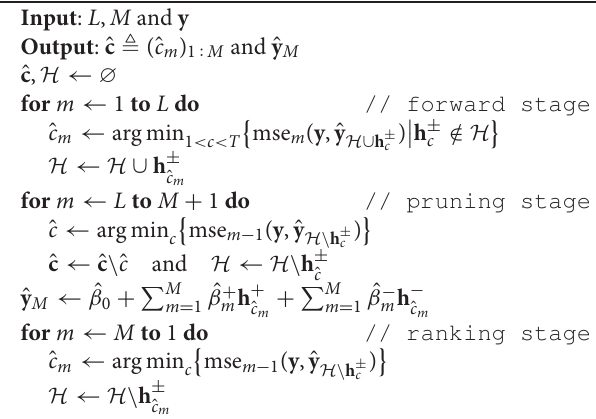
Algorithm 1: Procedure for inferring the PARCS M model with forward/backward spline selection (first/second loop) and CP ranking (third loop). Regression coefficients are computed by least squares estimation, conditioned on the set of knot locations of predefined size M that minimizes mean-square-error. Final knot locations are specified by eliminating spurious knots through block-permutation bootstrapping as described in Section 2.3.